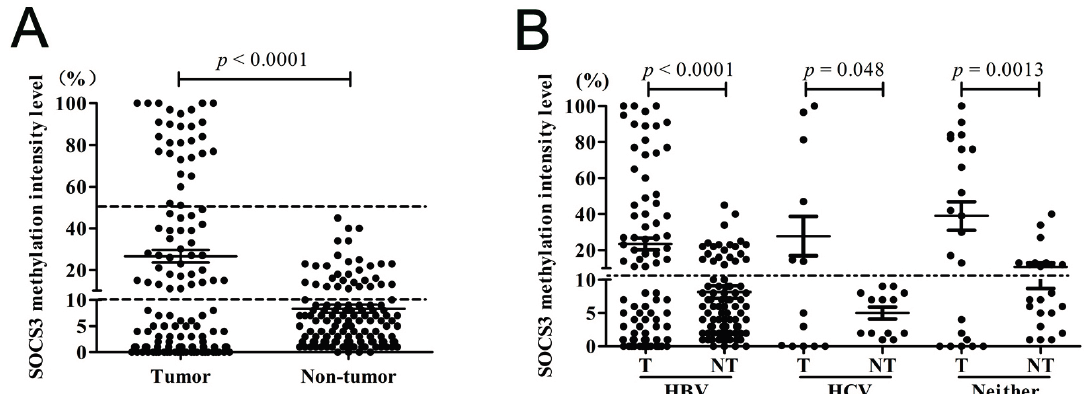
Figure 3. The methylation statuses of SOCS3 at region 2 in HCC tumor and adjacent non-tumor tissues. ( A ) The methylation status in 127 enlarged paired tumor tissues and non-tumor tissues; and ( B ) the methylation status in tumor tissues and adjacent non-tumor tissues with different virus infection backgrounds.